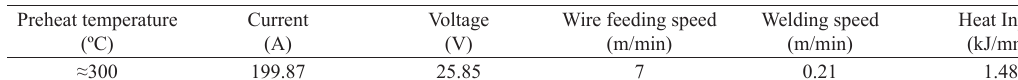
Table 5. Buttering weld